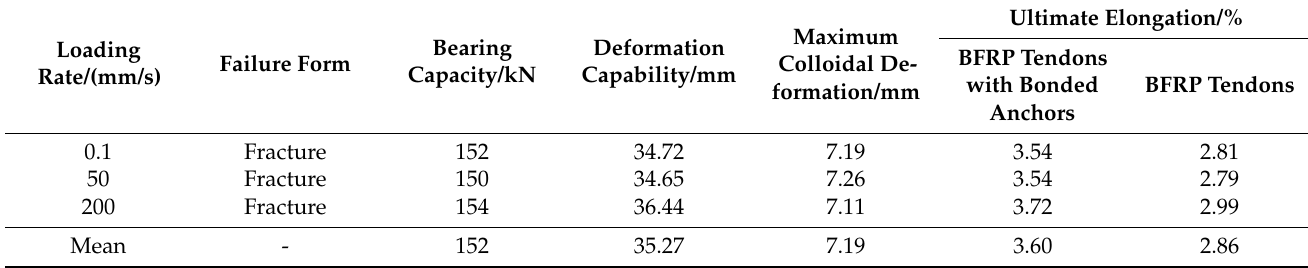
Table 1. Summary of the monotonic behavior of the BFRP tendons.